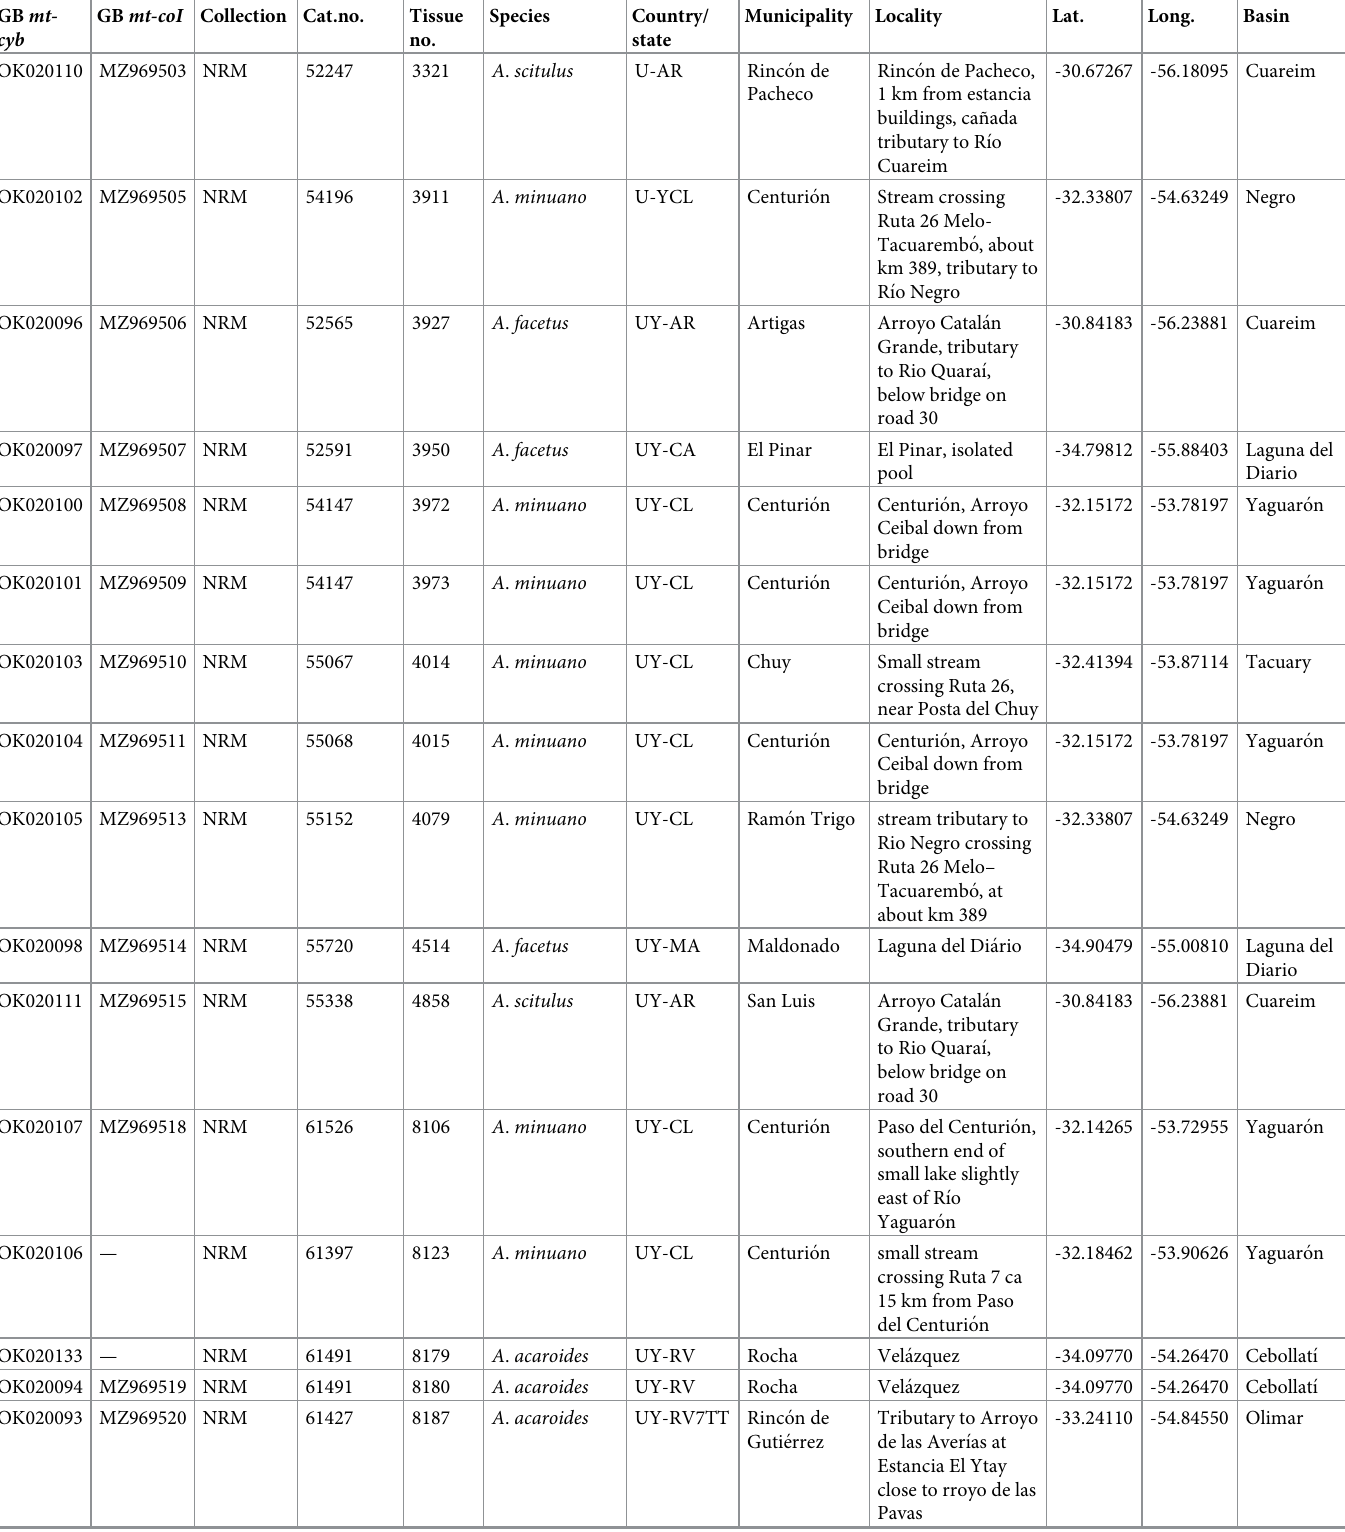
Table 1. New sequences of Australoheros and Cichlasoma generated, with GenBank accession numbers, collection identifiers, and collection site. GB mt- GB mt-coI Collection cyb